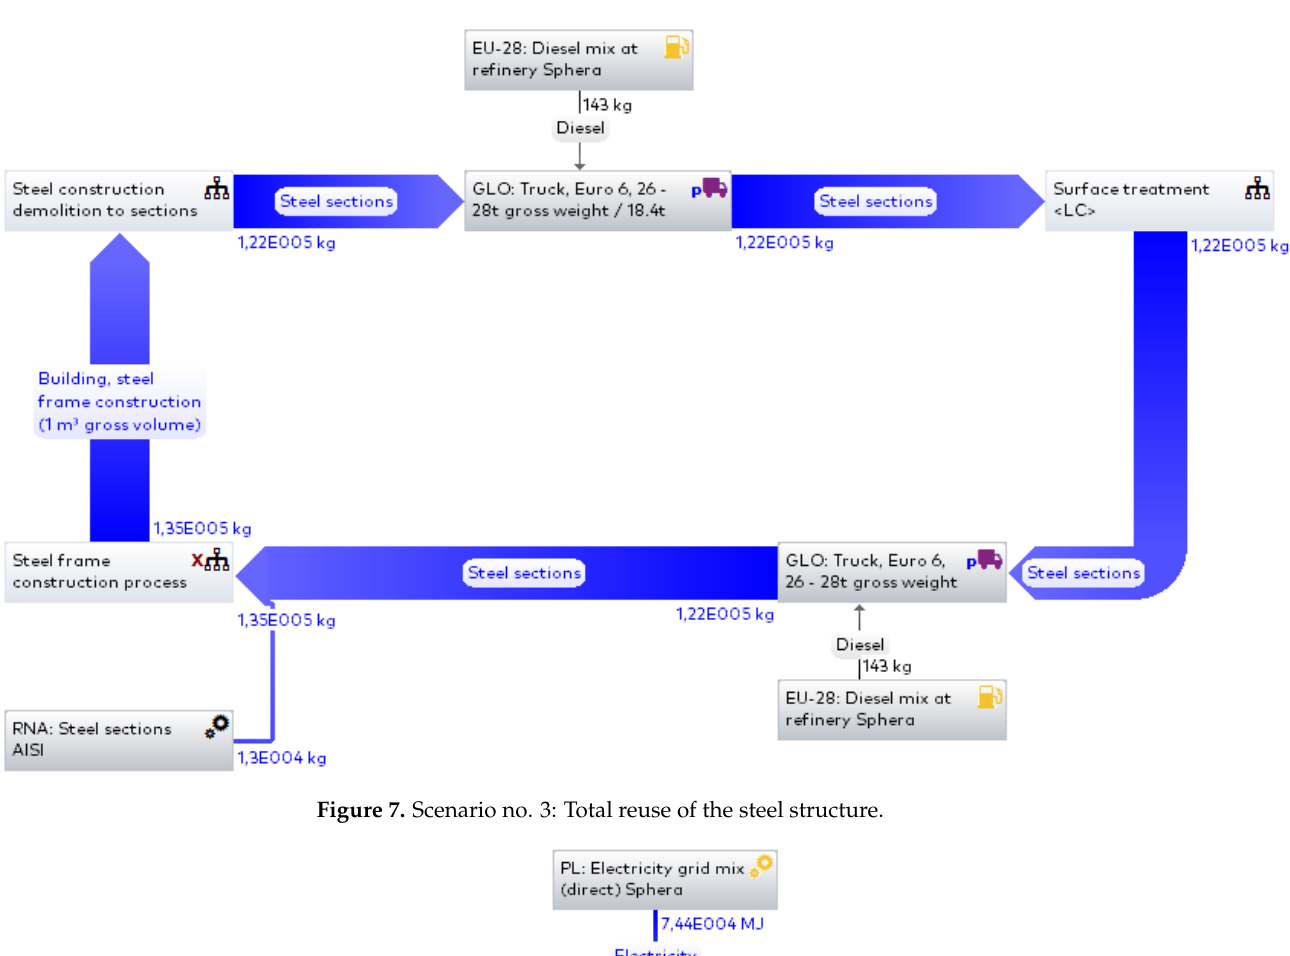
Figure 6. Scenario no. 2: Partial reuse of steel structure components and remelting the rest.